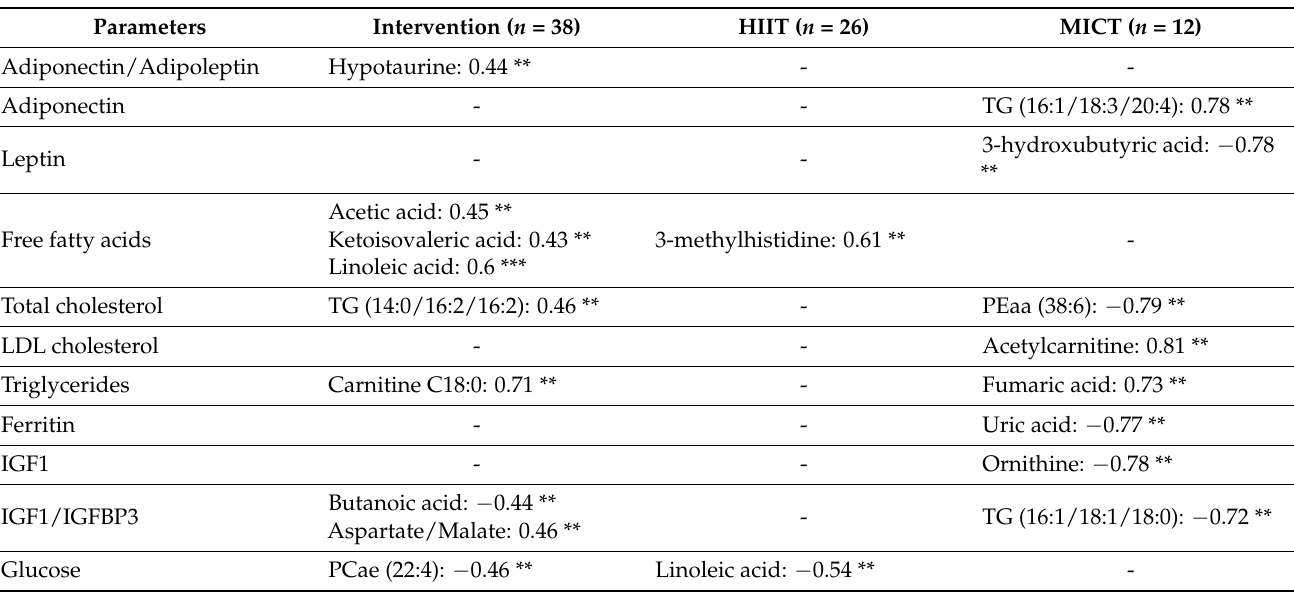
Table 6. Significant correlations between biological parameters delta changes and significant metabo- lites delta